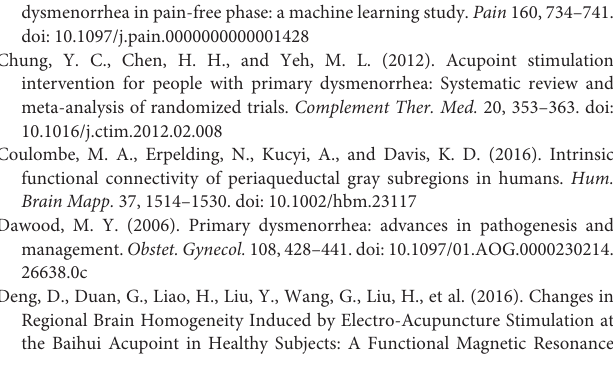
Supplementary Figure 1 | Flow chart of fMRI